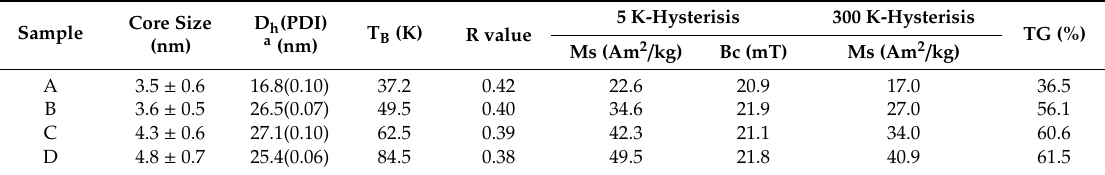
Table 1. Core size, magnetic properties of the synthesized MHFn nanoparticles.